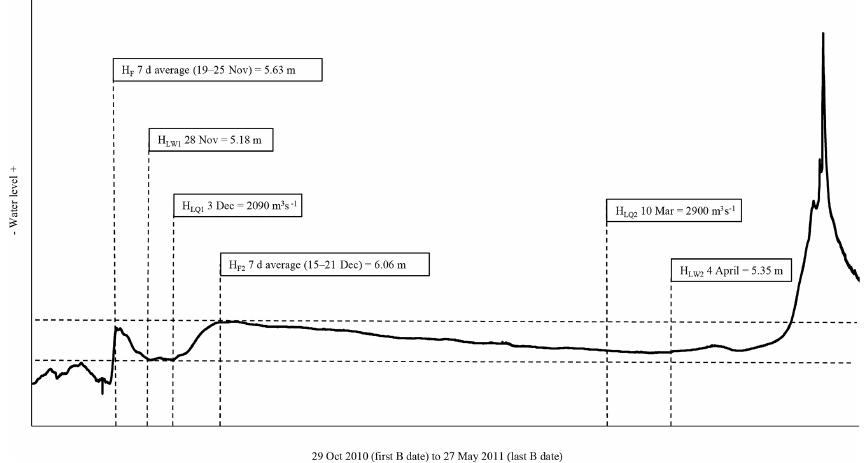
Figure 8. Continuous water level record for Mackenzie River at Norman Wells during the 2010–2011 ice-affected flow period. Note the occurrence of a higher magnitude 7d average following H F2 in comparison to H F and the corresponding second winter minimums (H LW2 and H LQ2 ) in addition to the first occurrence (H LW1 and H LQ1 ).